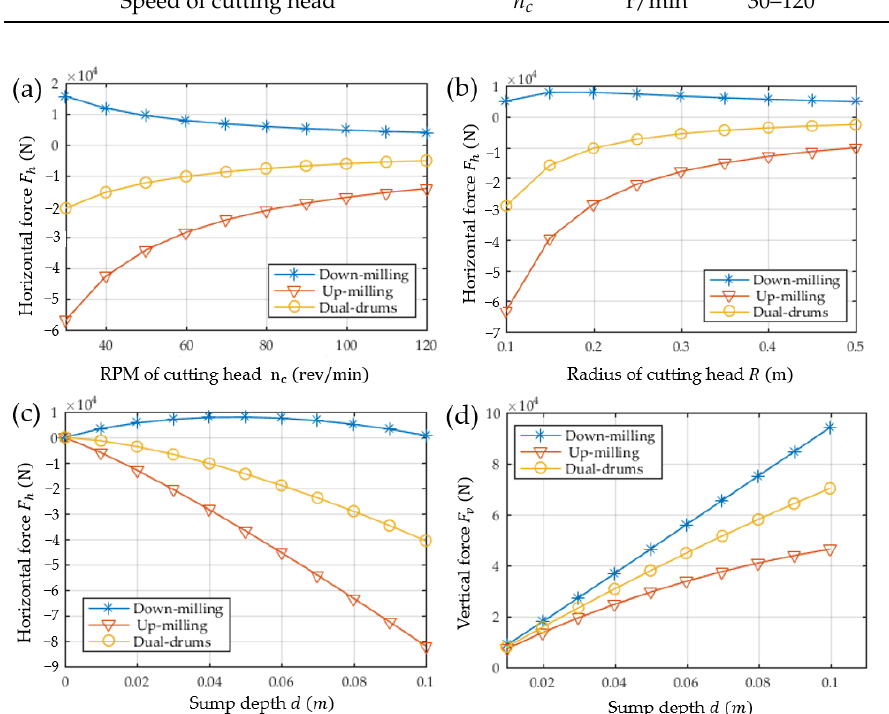
Figure 3. Effects of cutting head parameters on cutting resistance. ( a ) Effect of cutting speed on horizontal force. ( b ) Effect of cutting head radius on horizontal force. ( c ) Effect of sump depth on horizontal force. ( d ) Effect of sump depth on vertical force.